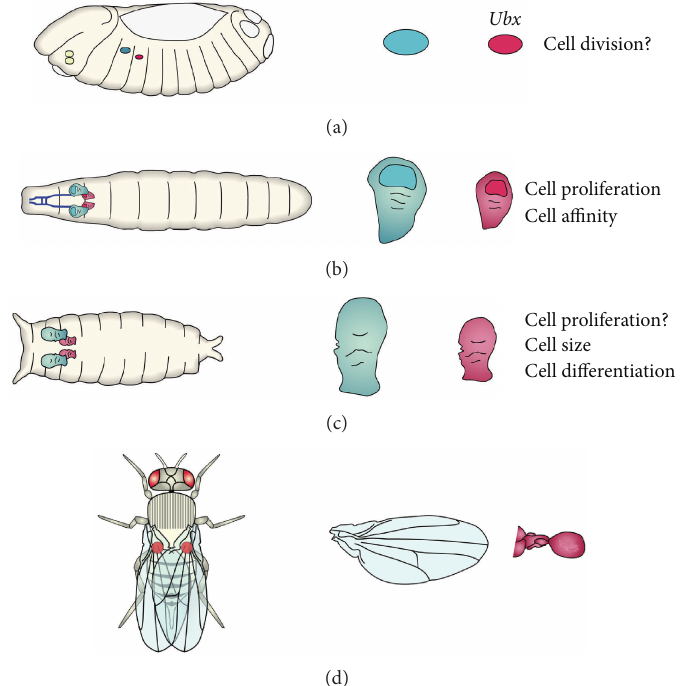
Figure 1: Different processes that lead to the development of halteres instead of wings by Ubx . Halteres and haltere discs are in red, whereas wings and wing discs are in blue. (a) At the end of the embryonic development, Ubx activity makes the haltere disc about half the size of the wing disc. (b) During larval development, Ubx regulates many signaling pathways to determine haltere disc size and to specify haltere development. (c) During pupation, Ubx reduces cell size in the haltere disc as compared to that of the wing disc and also determines cell differentiation. The final result is the development of a haltere instead of a wing